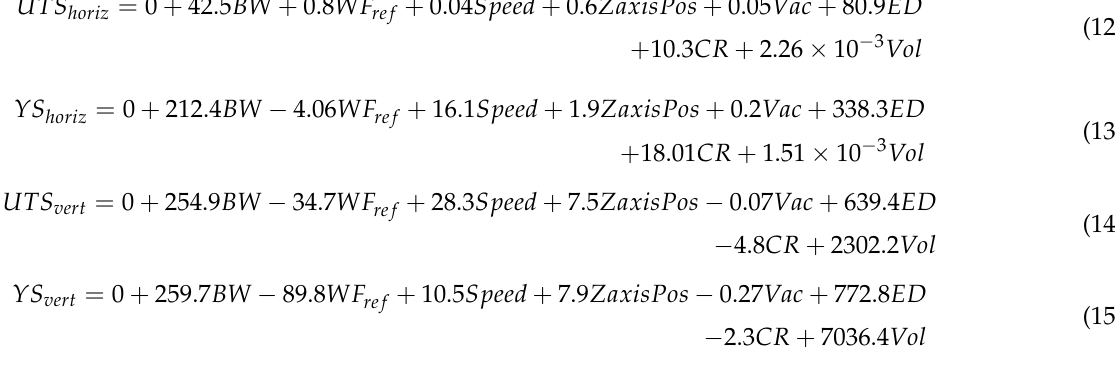
Table 6. R 2 values for predicted UTS and YS for the horizontal and vertical components utilizing a range of values for the volume in the z , or vertical, direction in order to optimize the accuracy of the predicted results for all components of the stresses.